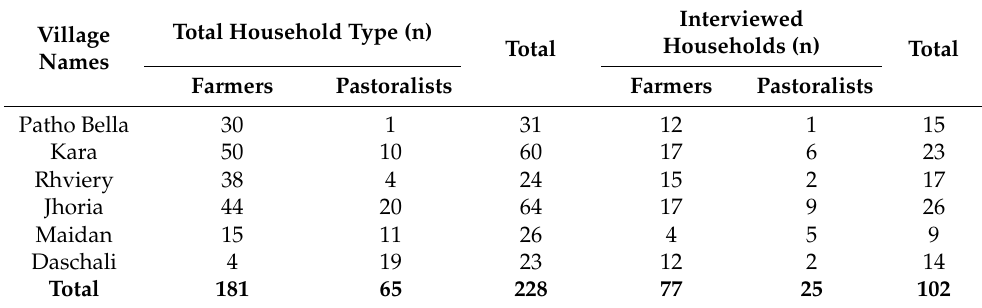
Table 1. Sampling of the households in